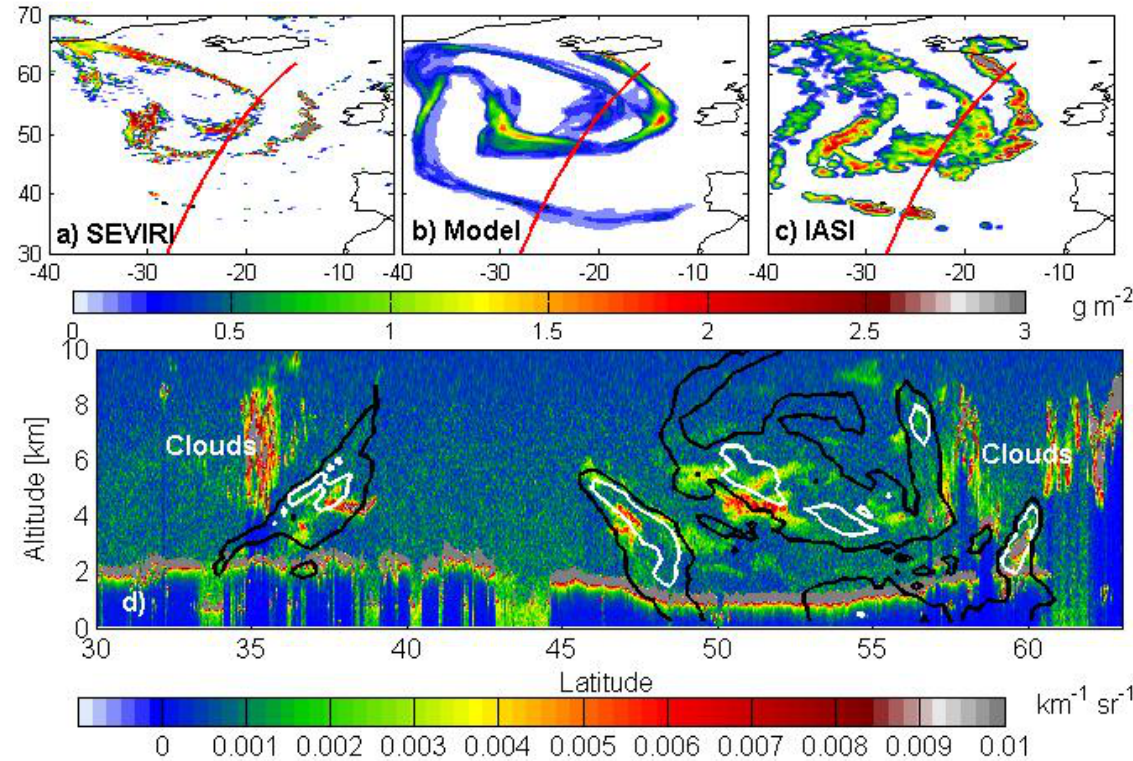
Fig. 7. Comparison between satellite-retrieved and modeled ash on 10 May 2010. (a) Ash total columns retrieved from geosynchronous satellite observations (SEVIRI) between 03:00–04:00UTC (notice that the plot shows data from a larger domain than that used for the inversion). (b) A posteriori modeled ash total columns averaged between 03:00–04:00UTC, (c) Ash total columns retrieved from IASI data from several overpasses of the polar orbiting satellite between 10:00–13:00UTC. The red line in (a–c) shows the track of the space-borne CALIOP lidar overflying the ash plume. (d) Vertical cross-section along the red line shown in (a – c) of total attenuated backscatter at a wavelength of 532nm obtained from space-borne lidar (colored) superimposed with 20µgm − 3 (black line) and 200µgm − 3 (white line) isolines of volcanic ash concentrations from the model simulation. Features near 35 ◦ N and north of 57 ◦ N and above 5km are ice clouds (see labels). Also the layer extending from 30–60 ◦ N near 2km altitude are clouds.